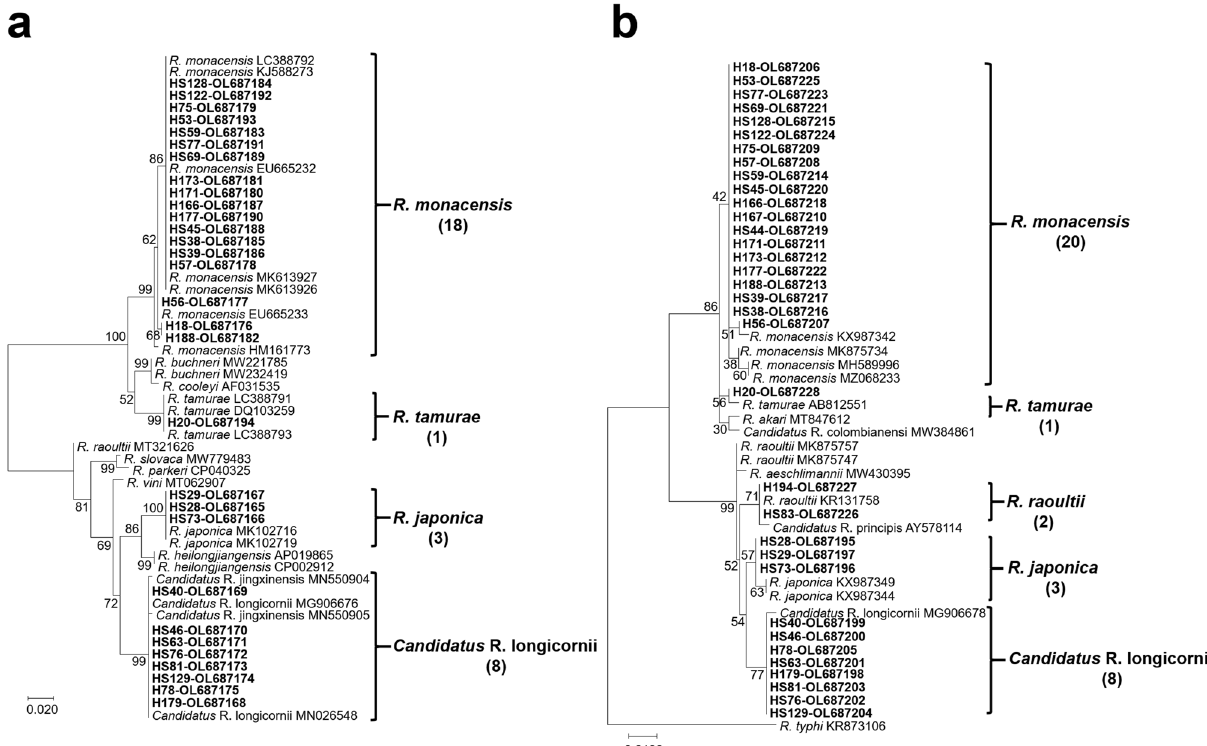
Figure 1. Phylogenetic tree of Rickettsia spp. detected from bird ticks. ( a ) Phylogenetic tree based on ompA gene fragment sequences ( b ) gltA gene fragments showed that Rickettsia spp. belonged to five species: R. monacensis, Candidatus R. longicornii , R. japonica, R. raoultii, and R. tamurae . The number of pooled samples for each species is in parentheses. The unique collection/assay number for each tick pool positive for Rickettsia spp. and NCBI accession numbers are